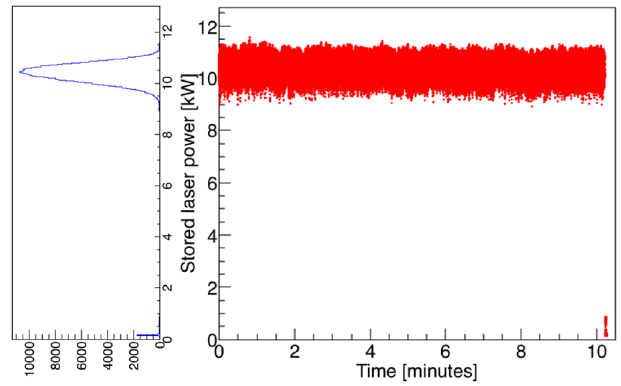
FIG. 18. Stability of the stored laser power in the optical cavity.